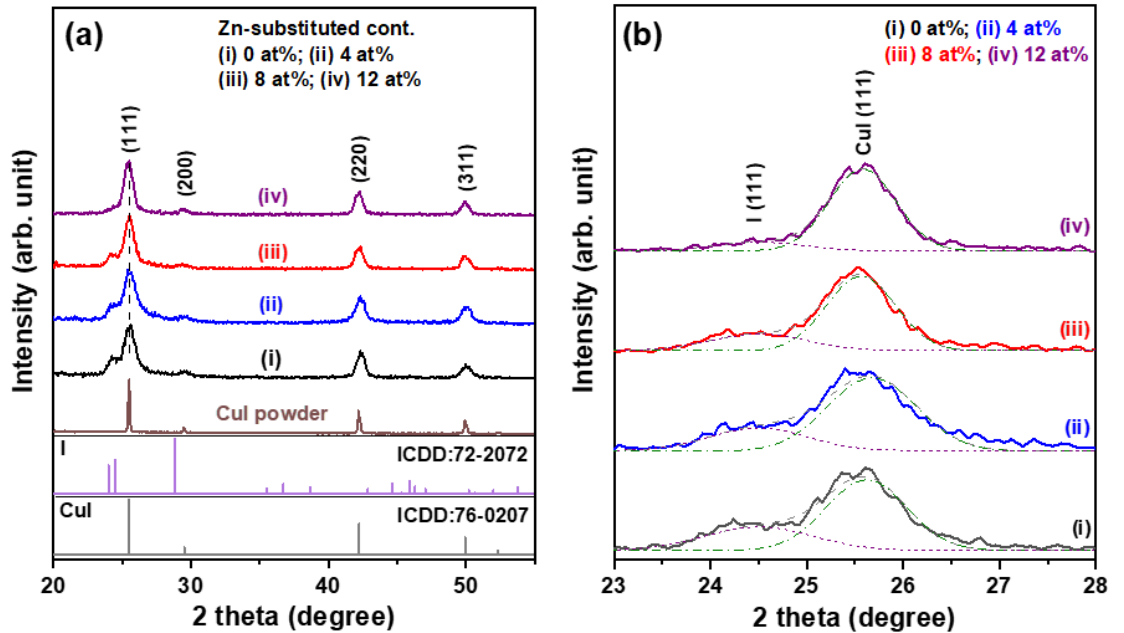
Figure 2. ( a ) XRD patterns of solution-processed Zn-substituted CuI thin films. ( b ) an enlargement plot of the CuI (111) diffraction peaks for the corresponding thin film samples. Table 1. Comparison of microstructural, optical and electrical characteristics of solution-processed Zn-substituted CuI thin films.